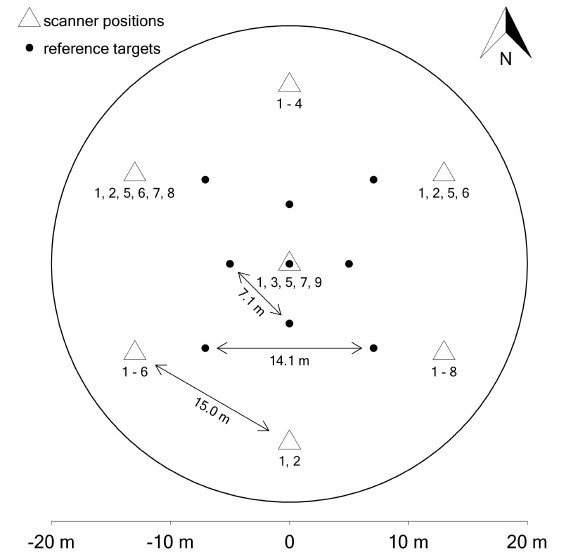
Figure 1. Scan settings. Numbers below scanner positions (marked as triangles) denote scan variants in which each respective scanner position was used. For the most intensive scan variant, variant 1, the distance between each neighboring scanner position (triangle) was constantly 15 m. The Styrofoam balls as reference targets (filled circles) were located in two concentric squares. The outer square had a side length of 14.1 m and the distance of each reference target to the center was 10 m. The inner square had a side length of 7.1 m and the distance of each reference target to the center was 5 m. In addition, the two squares were rotated by 45 ◦ . In scan variants without a central scan (2, 4, 6, 8), an extra reference target was placed at the center